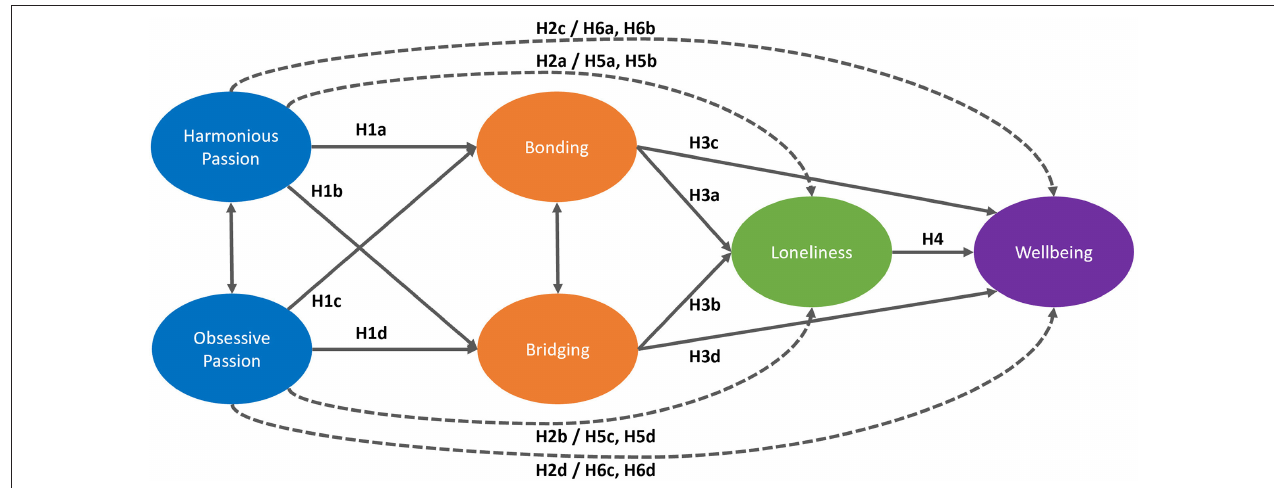
FIGURE 1 | The hypothesized Structural Equation Model. Error terms for the measured items are not shown. Dashed lines indicate that we assumed direct and indirect effects for these paths.